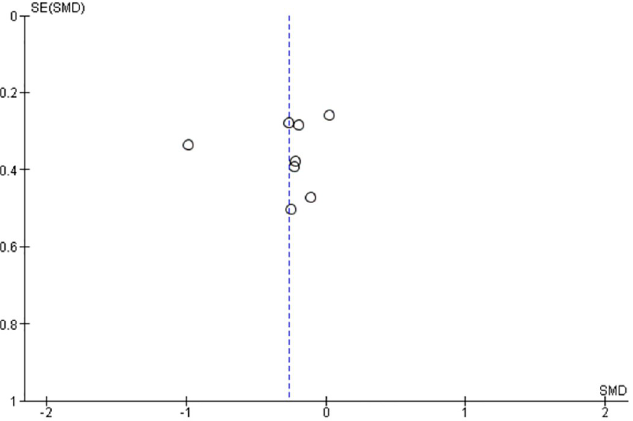
Fig 5. Preliminary funnel plot of incremental AUC at the selected studies for Normal-Intakes " < 10g" and control.